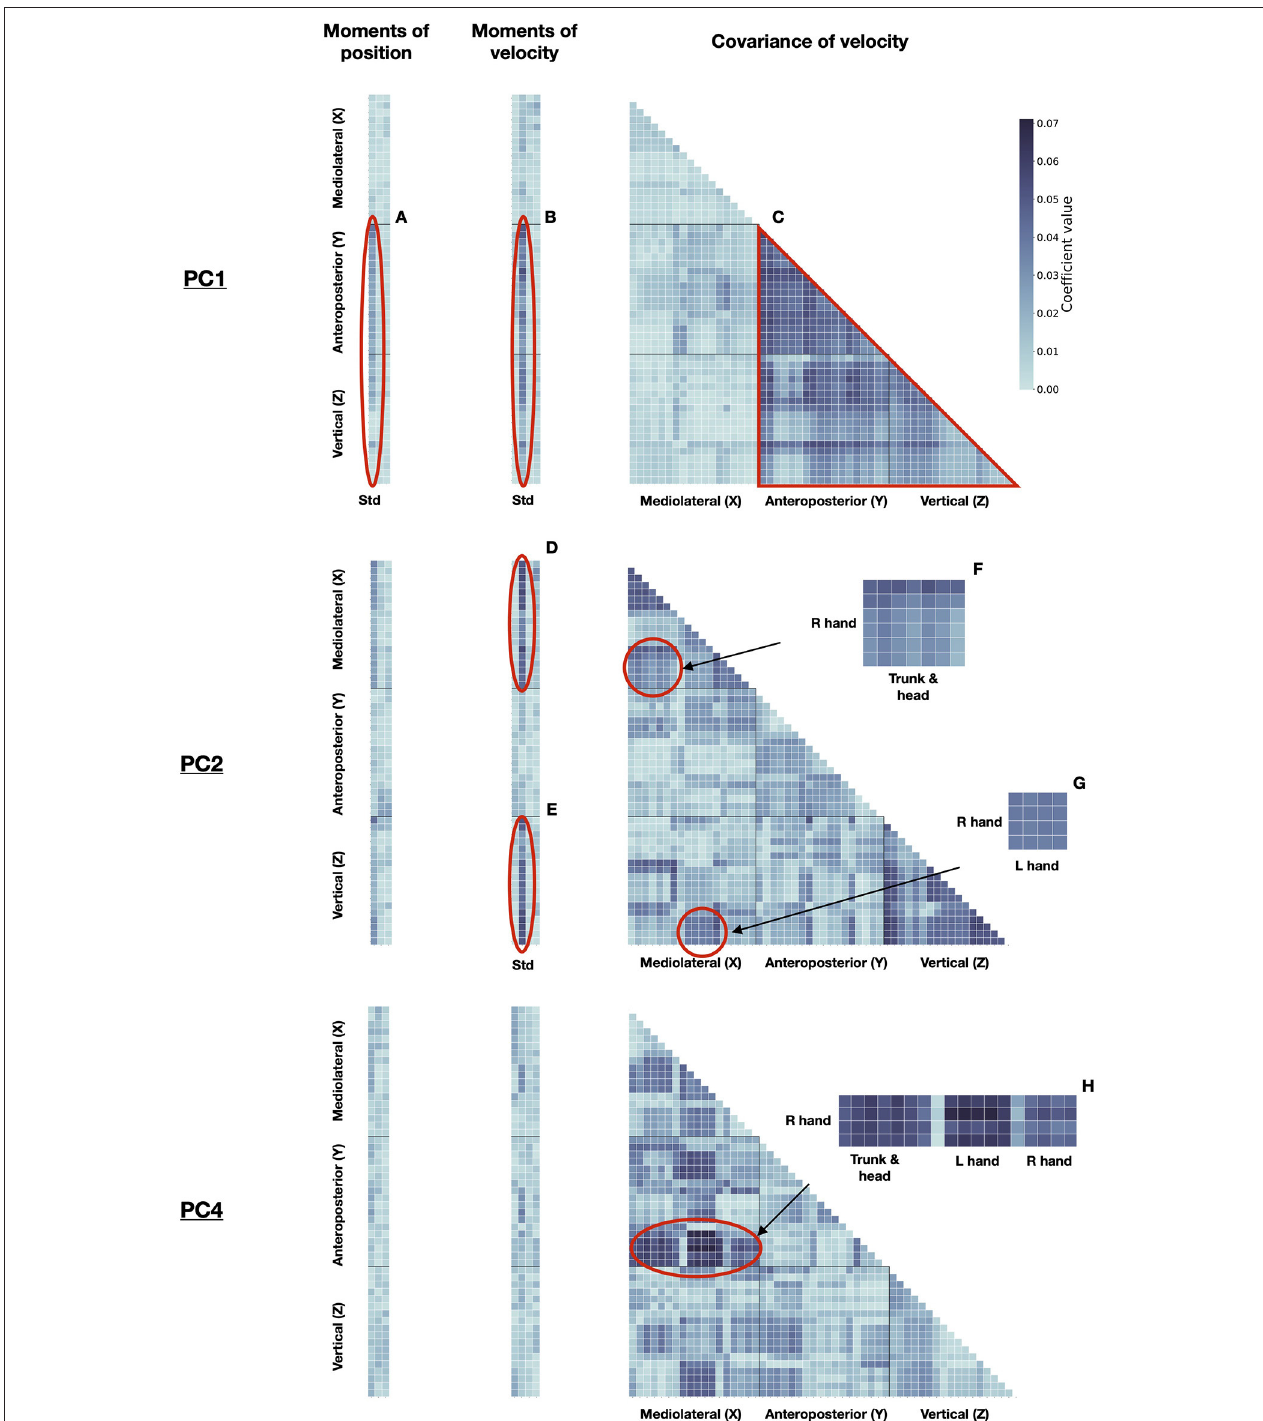
FIGURE 6 | Discriminant PCs for signer identification. Left: moments (columns: std, skew, kurtosis) of position, for all markers (rows). Middle: moments (columns: mean, std, skew, kurtosis) of velocity, for all markers (rows). Right: covariance of velocity between markers (rows and columns). Markers are sorted from 1 to 19 as presented in the Methods along X, Y, and Z axes. Some patterns of importance are highlighted. For the sake of clarity, the specific moments and body markers are displayed only for these patterns of importance. PC1: Std of position (A) and velocity (B) along Y and Z axes, for all markers; (C) Covarying movements between all markers along Y and Z axes. PC2: Std of velocity along X (D) and Z (E) axes, for all markers; (F) Covarying movements between the right hand, and trunk, and head markers, along X -axis; (G) Covarying movements between the right hand markers along Z -axis, and the left hand markers along X -axis. PC4: (H) Covarying movements between the right hand markers along the Y -axis, and all other markers along the X -axis.